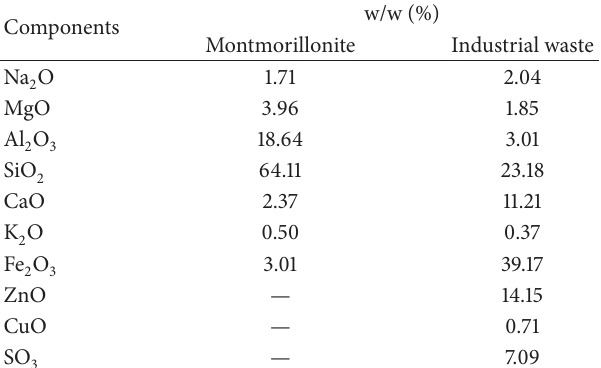
Table 1: Chemical compositions of the materials.